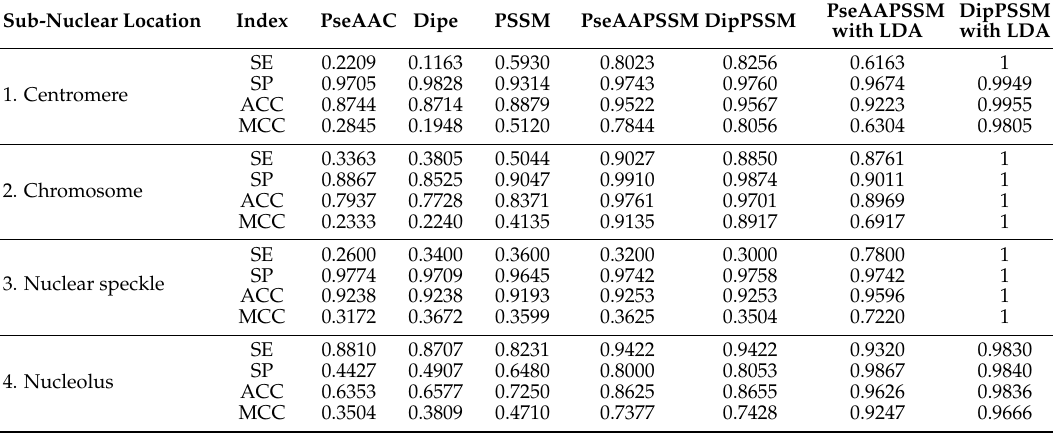
Table 7. Performance of various representations on Dataset